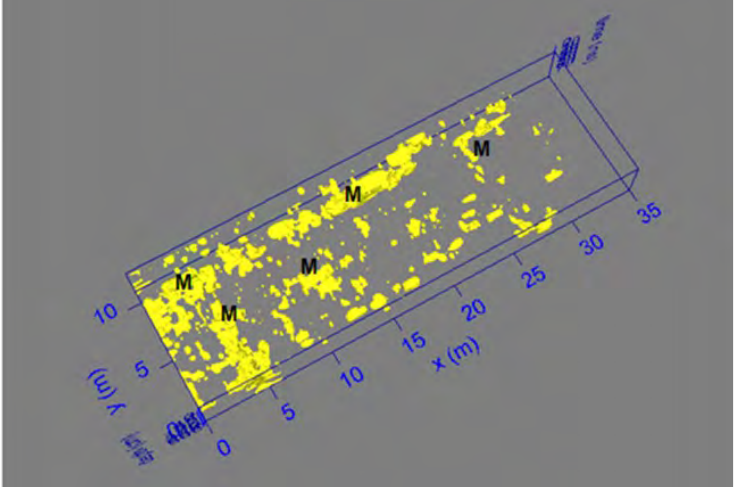
Figure 6. 3D amplitude iso-surface